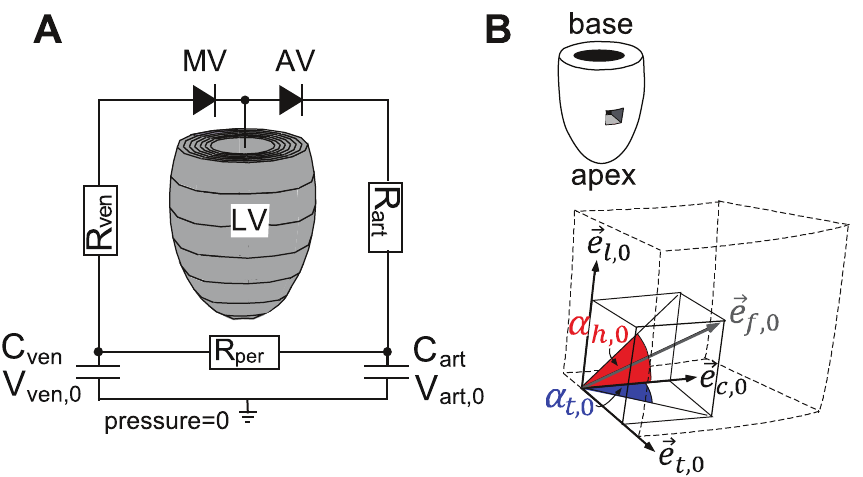
Figure 2. Computational model of LV mechanics. A : The ellipsoidally shaped finite element (FE) mesh of the left ventricle (LV) consists of 60 elements and is incorporated in a lumped parameter model of the circulation. AV, aortic valve; C art , arterial compliance; C ven , venous compliance; MV, mitral valve; R art , arterial resistance; R per , peripheral resistance; R ven , venous resistance; V art ,0 , zero-pressure arterial volume; V ven ,0 , zero-pressure venous volume. B : Description of myofiber orientation vector in the unloaded state ~ ee f ,0 by helix angle a h ,0 and transverse angle a t ,0 using a local